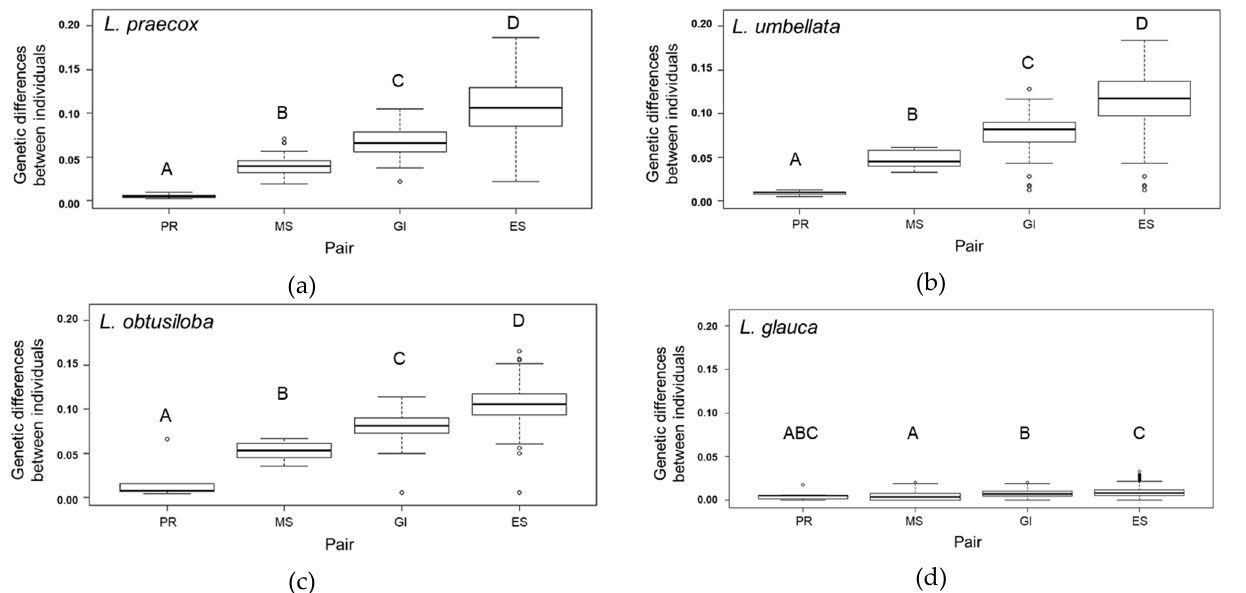
Figure 1. Boxplot of the genetic difference between individuals of ( a ) Lindera praecox , ( b ) L. umbellata , ( c ) L. obtusiloba, and ( d ) L. glauca (Lauraceae). The box represents the interquartile range (25th–75th percentiles); while the line across the box indicates the median. Whiskers extend to the 1.5-fold of the interquartile range. The circles indicate outliners. Values denoted by the same letters are not significantly different from each other at p < 0.05 (Kruskal-Wallis test and Wilcoxon test with sequential Bonferroni correction). PR; the possibility that pseudo-variant loci occurred originating from PCR errors, MS; the genetic difference between mother plants and their seeds, GI; the genetic difference between grown-up individuals by parings individuals growing in the same location, and ES; the genetic difference calculated for all pairs of grown-up individuals after combining all individuals sampled from all locations into a single pool.